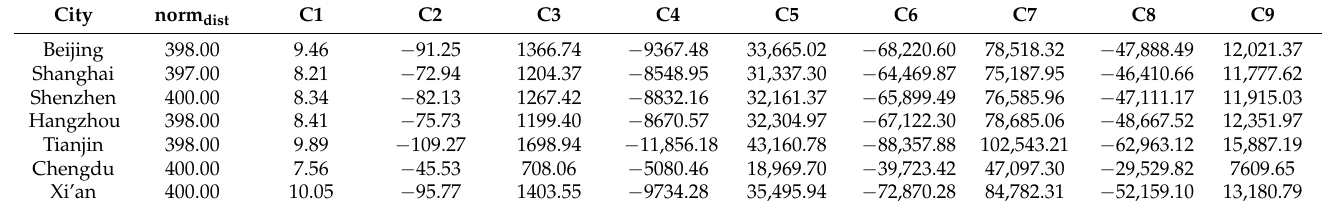
Figure 4. Standard UF and Actual UF.